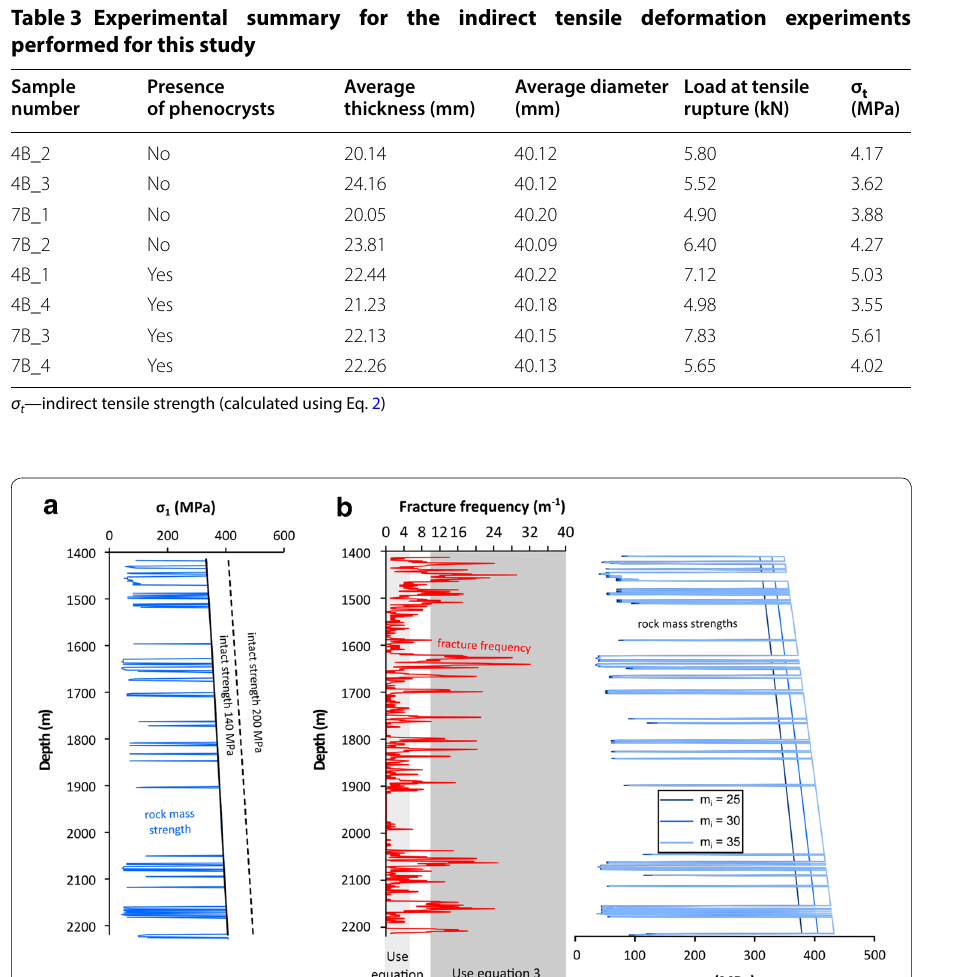
Table 3 Experimental summary for the indirect tensile deformation experiments performed for this study